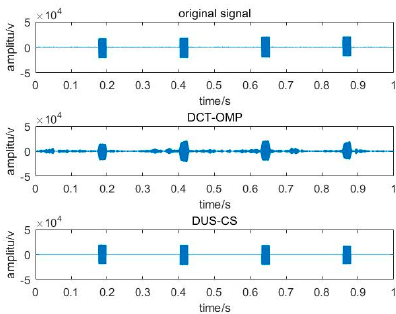
Figure 9. Nyquist sampling and reconstruction results.